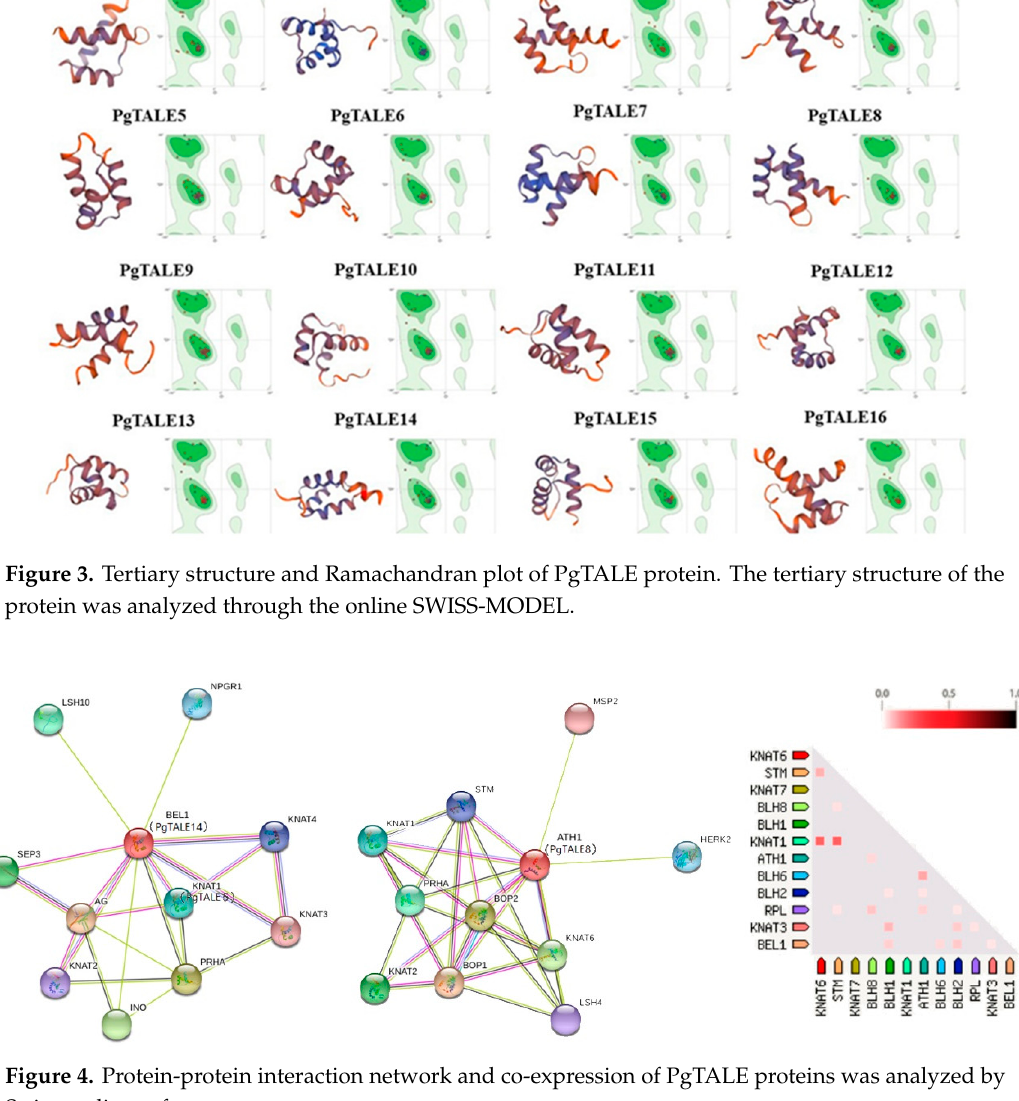
Figure 5. Cis-elements analysis of PgTALE genes. Note: ABRE involved in the abscisic acid responsiveness; ARE involved in anaerobic responsiveness; AuxRR-core and TGA-element involved in auxin responsiveness; CAAT-box involved in promoter and enhancer regions; CGTCA-motif and TGACG-motif involved in the MeJA-responsiveness; GARE-motif, P-box and TATC-box involved in gibberellin-responsiveness; LTR involved in low-temperature responsiveness; MBS involved in drought-inducibility; TCA-element involved in salicylic acid responsiveness.